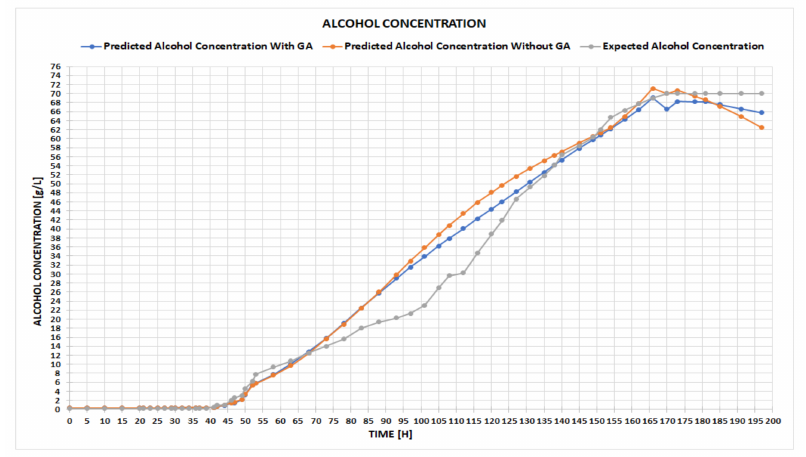
Figure 10. Alcohol prediction, based on different types of weights